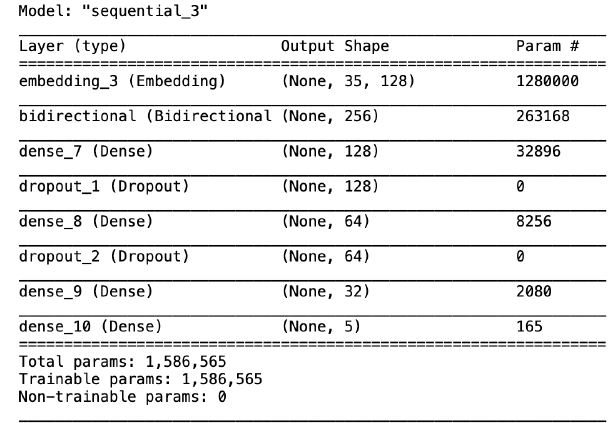
Figure 4. Architecture of our LSTM model.